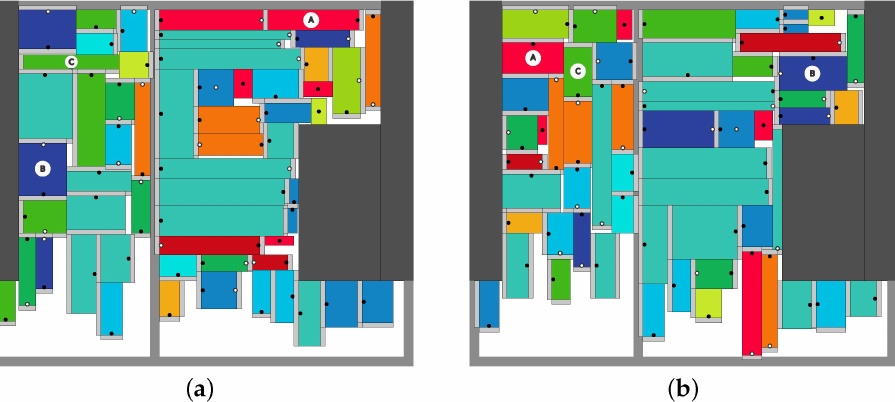
Figure 7. Examples of two floor plans using different workstation variants: ( a ) a floor plan with maxFreeSpace = 10.010m 2 and minCost = 261.500. ( b ) a floor plan with maxFreeSpace = 10.620m 2 and minCost = 243.900. Workstations marked with ‘A’, ‘B’, and ‘C’ are examples of workstations realized differently in the two floor